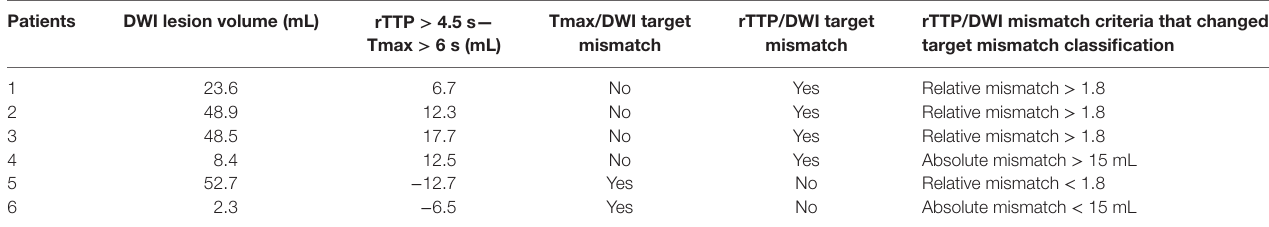
TaBle 3 | Overview of patients whose PWI/DWI mismatch classification differs depending on the use of Tmax vs. rTTP.